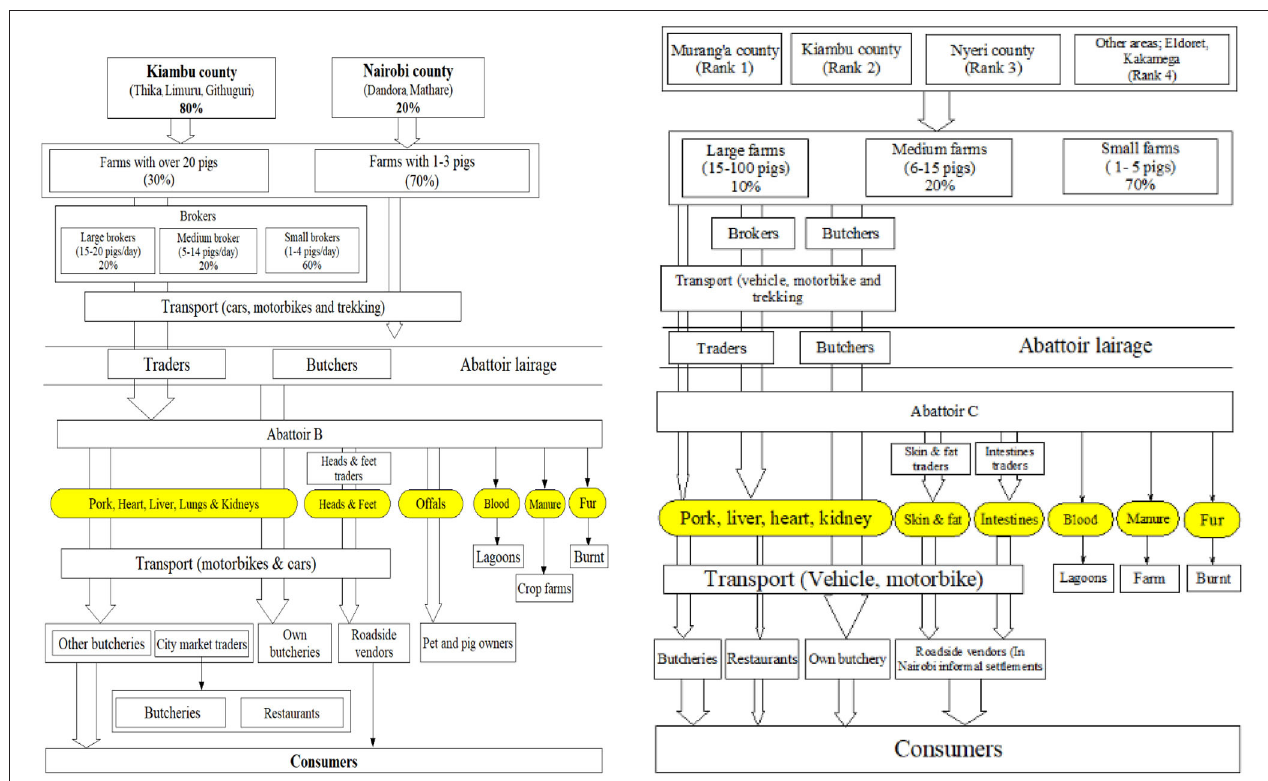
FIGURE 3 | Profile of people and product traded by abattoirs B and C. Oval shapes colored yellow indicates commodities traded; arrows indicate the flows of products. The arrow width indicates proportional importance in terms of